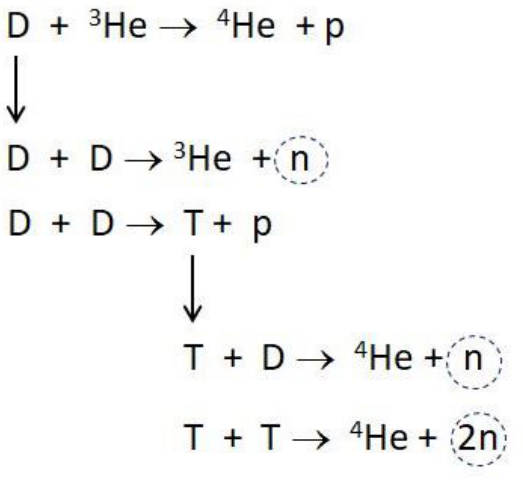
Figure 8. Illustration of non-aneutronic effects of deuterium–deuterium self-burn reactions within a deuterium–helium-3 dominant thermonuclear